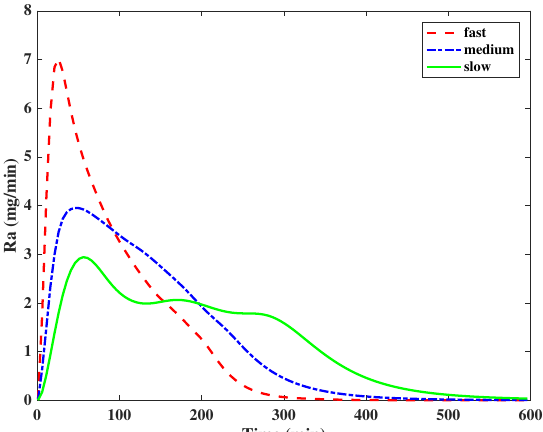
Figure 1. Average R a profiles corresponding to the fast, slow and medium meals from the UVa-Padova simulator for a 60 g intake of